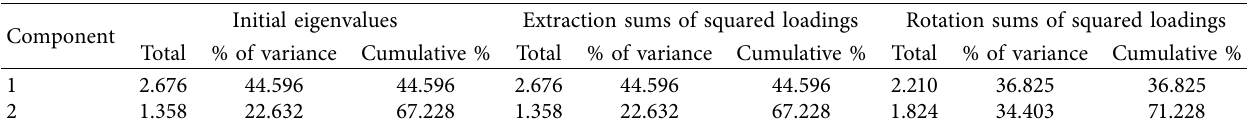
Table 6: Total variance explained.